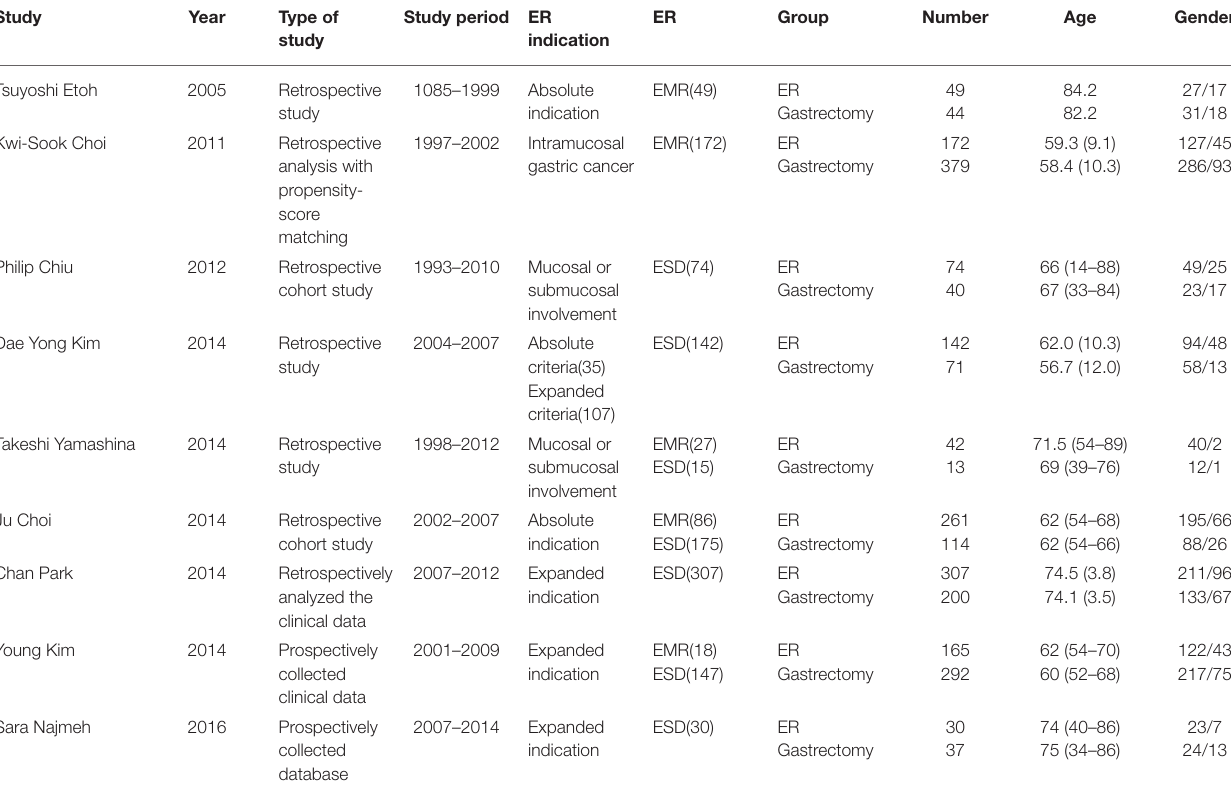
TABLE 1 | Characteristics of studies included in the